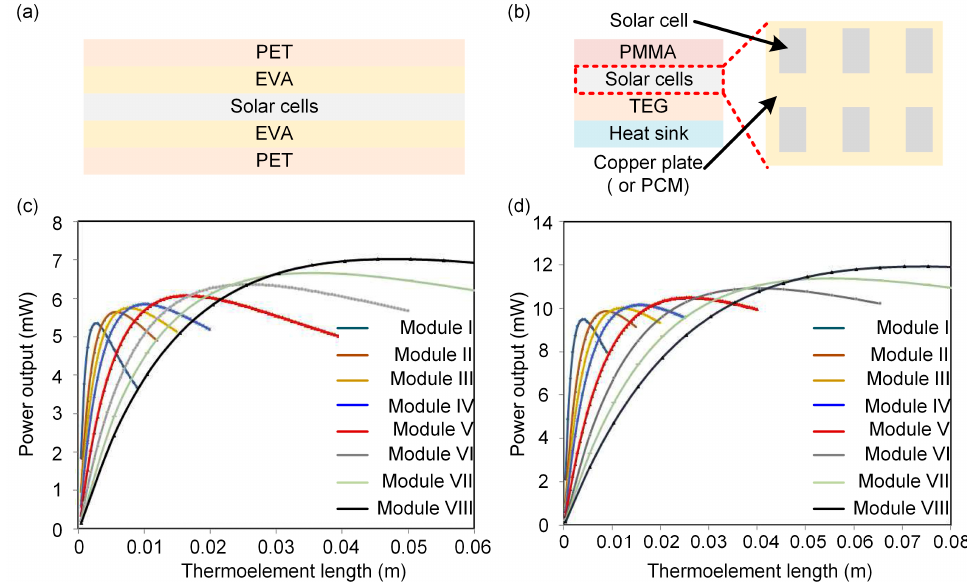
Figure 4. Schematic illustration of ( a ) covered PVC and ( b ) novel mosaic structure of PVC. Power output as a function of thermo-element length for system operation at ( c ) ambient and ( d ) vacuum atmosphere. Reprinted with permission from [85]. Copyright 2016, Elsevier.